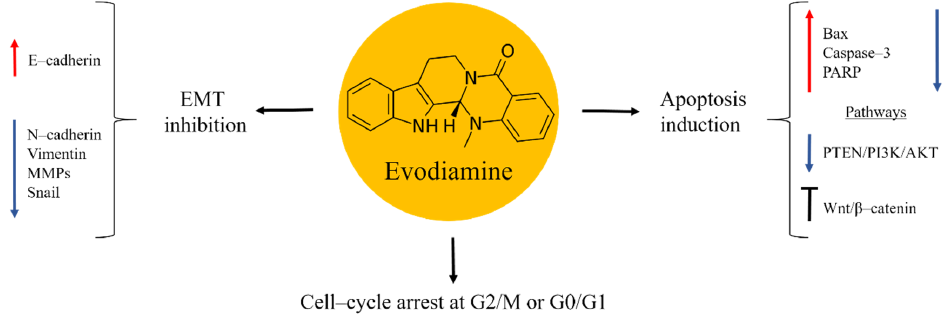
Figure 4. Evodiamine in osteosarcoma inhibition.